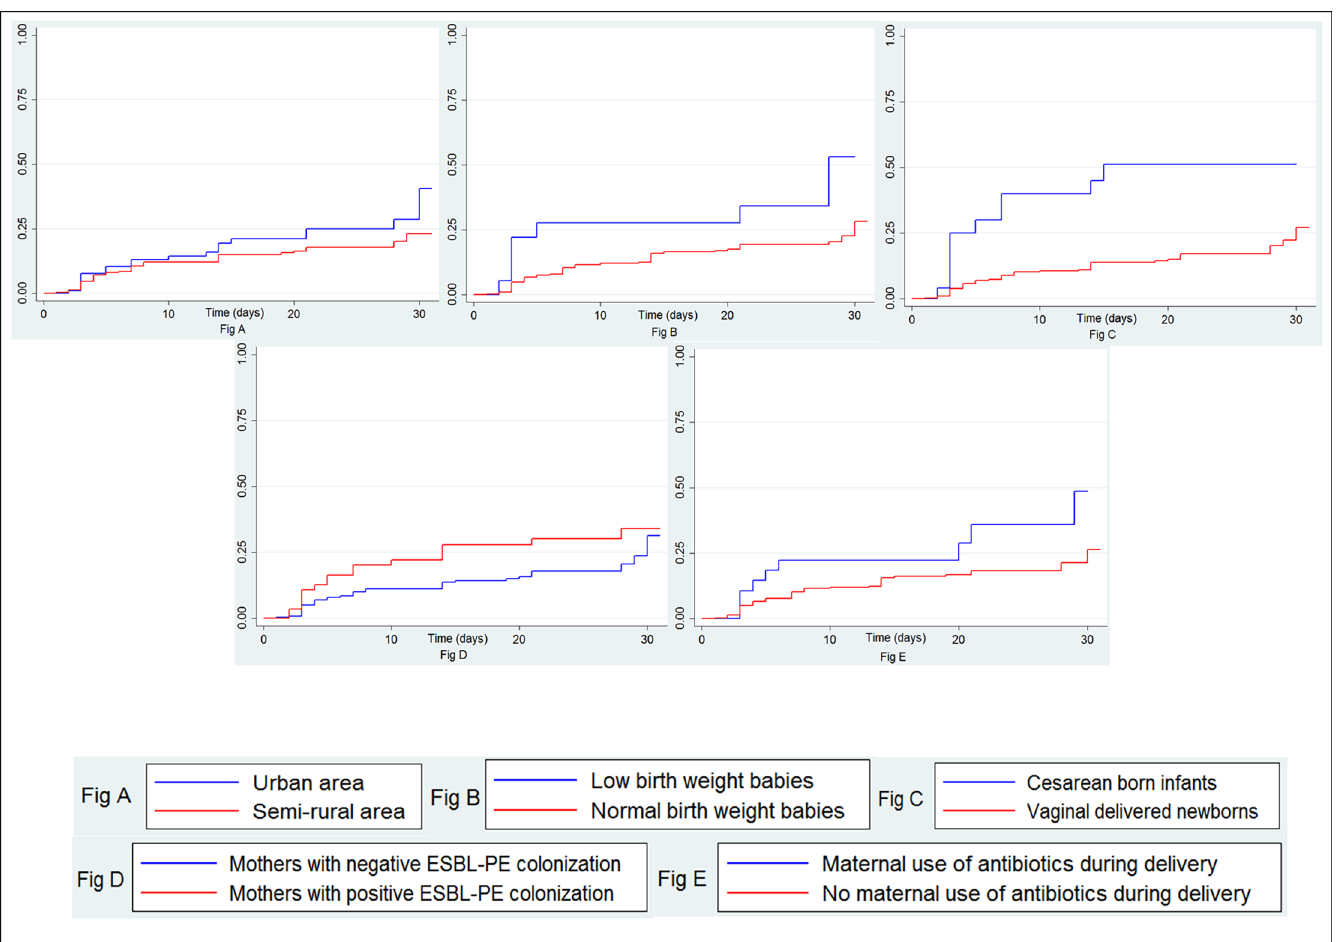
Fig 3. Cumulative incidences according to study areas (Fig 3A), newborn’s weight at birth (Fig 3B), mode of delivery (Fig 3), maternal ESBL-PE colonization status (Fig 3D) and antibiotics use during delivery (Fig 3E).